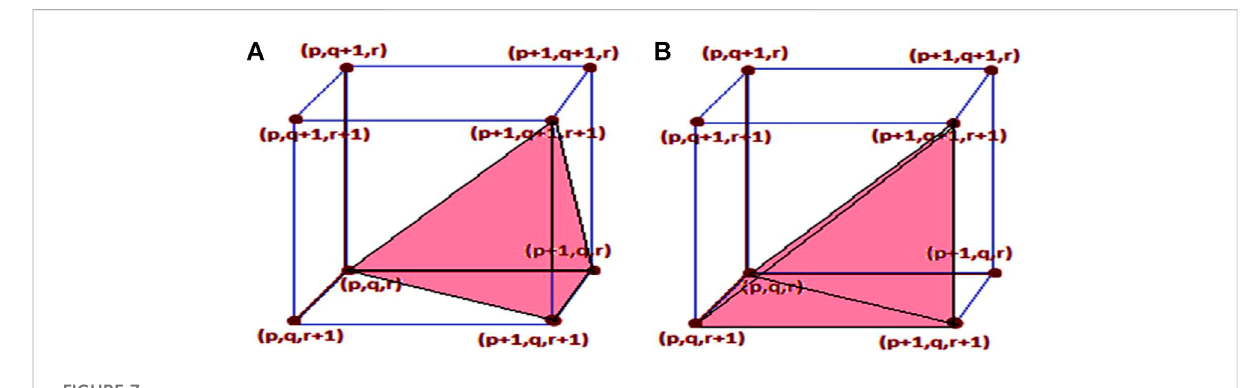
FIGURE 7 Reference vector location in prisms (A) Prism 1 (B) Prism